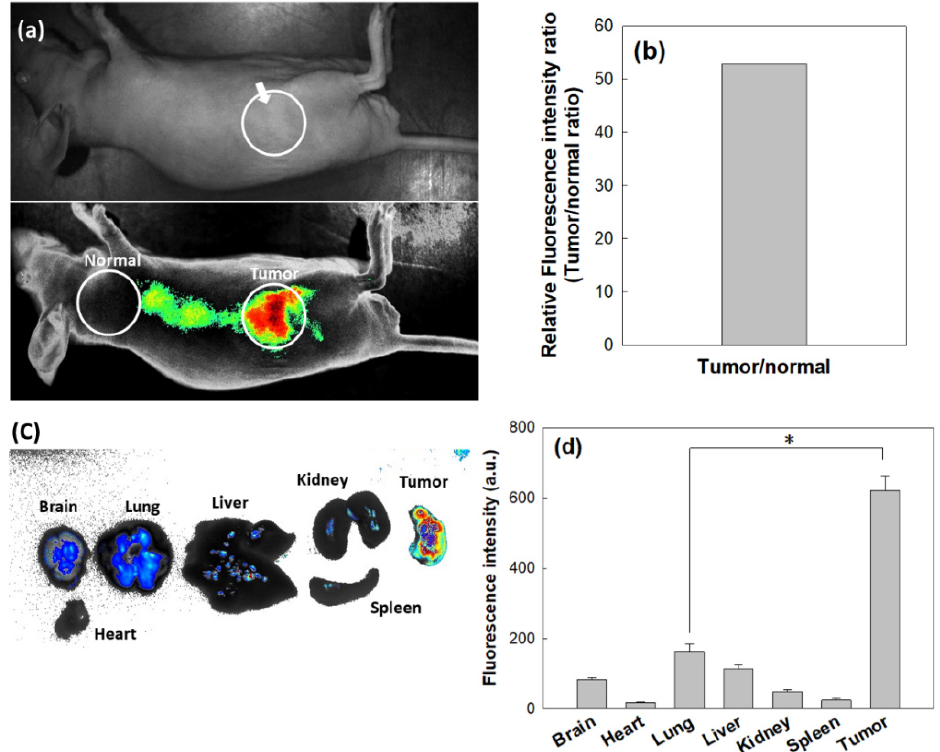
Figure 11. Animal tumor imaging using a KB cell-bearing tumor xenograft mouse model. ( a ) Fluorescence images of a whole mouse; ( b ) relative fluorescence intensity between tumor tis- sue vs. normal tissue; ( c ) fluorescence images of major organs; ( d ) fluorescence intensity of major organs. Nanophotosensitizer solution (10 mg Ce6/kg) was intravenously (i.v.) injected via the tail veins of the mice (Injection volume: 200 µ L). The whole bodies of the mice were observed with